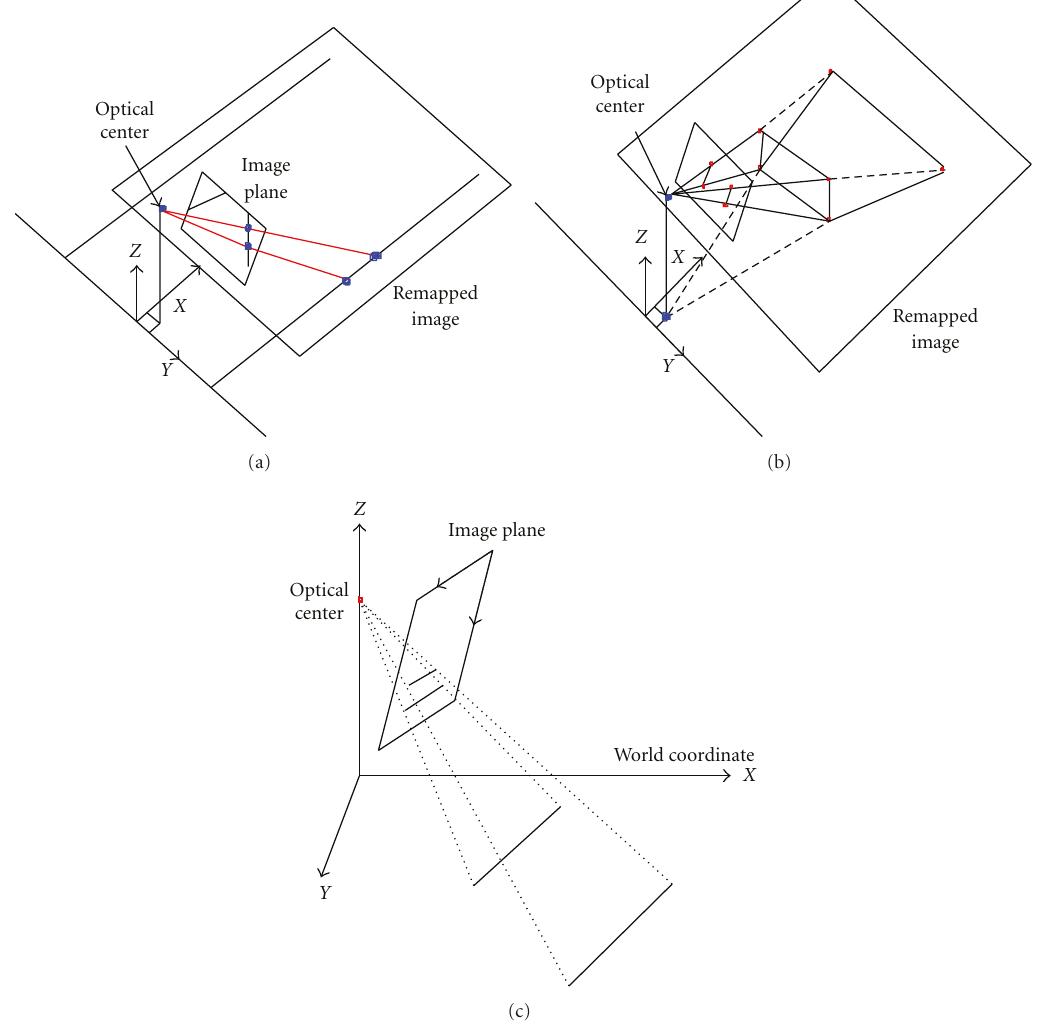
Figure 4: The figures and expected results for (a) perspective e ff ect removing (b) a vertical straight line in the image will be projected to a straight line whose prolongation will pass the vertical projection point of the camera on the world surface (c) a horizontal straight line in the image will be projected to a straight line instead of an arc on the world